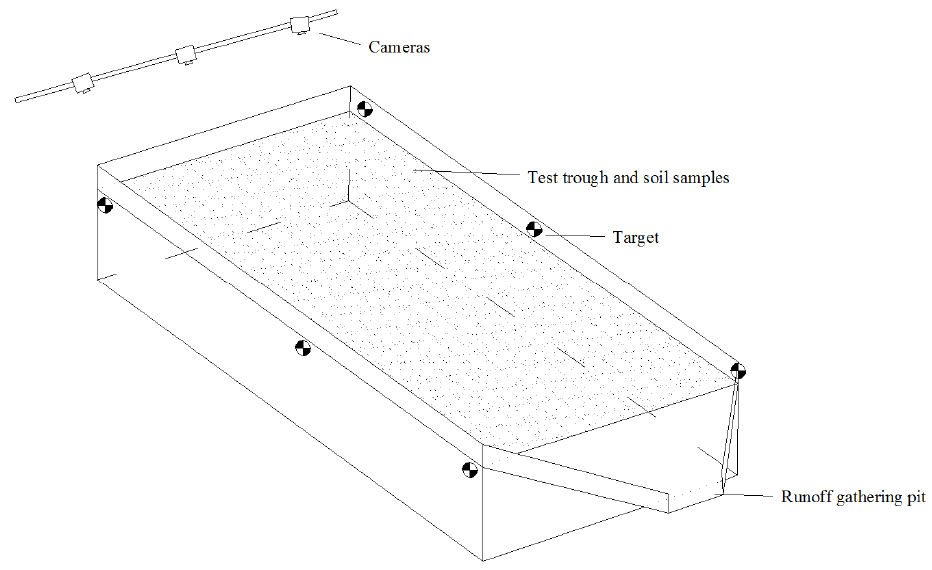
Figure 1. Schematic diagram of test device.